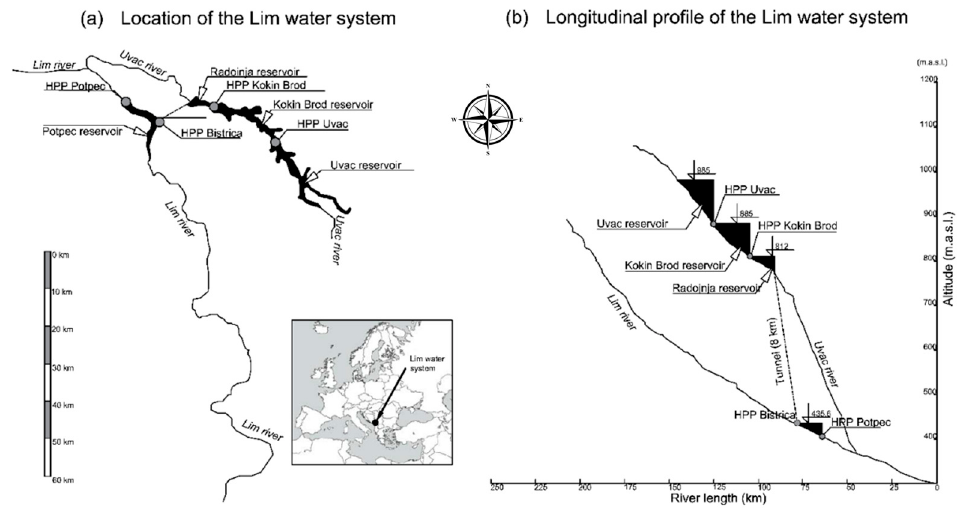
Figure 1. Location of the Lim water system reservoirs ( a ) together with the longitudinal profile ( b ). Table 1. The characteristics of reservoirs in the Lim water system.